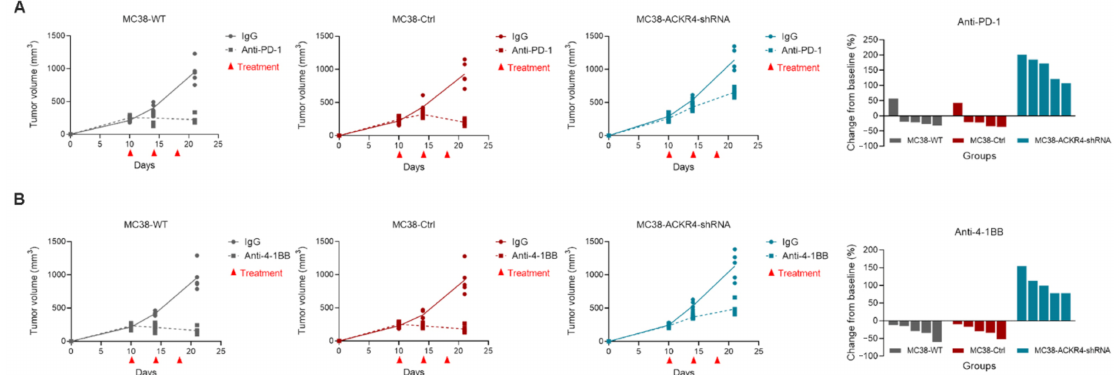
Figure 5. Immunotherapy response on MC38 tumors with different ACKR4 expression levels. ( A ) The mice were treated by anti-PD-1 on days 10, 14, and 18. The waterfall plot shows the individual tumor volume change post-treatment. The response of the ACKR4 knockdown group to anti-PD-1 treatment was worse than that of the other groups. ( B ) The anti-4-1BB agonist treatment showed similar results to the anti-PD-1 treatment. (WT: Wild type, Ctrl: Control, shRNA: Short hairpin RNA, PD-1: Programmed cell death protein 1, 4-1BB: CD137/Tumor necrosis factor receptor superfamily 9, IgG: Immunoglobulin G, ANOVA: Analysis of variance).